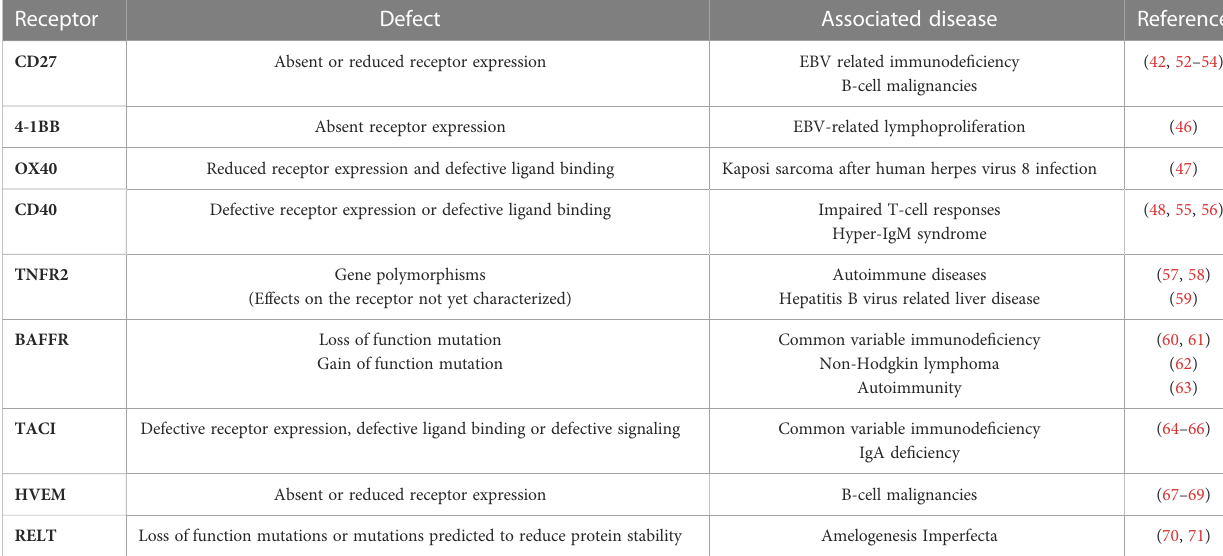
TABLE 1 TNFRSF co-stimulatory receptor dysregulation and disease development. Receptor